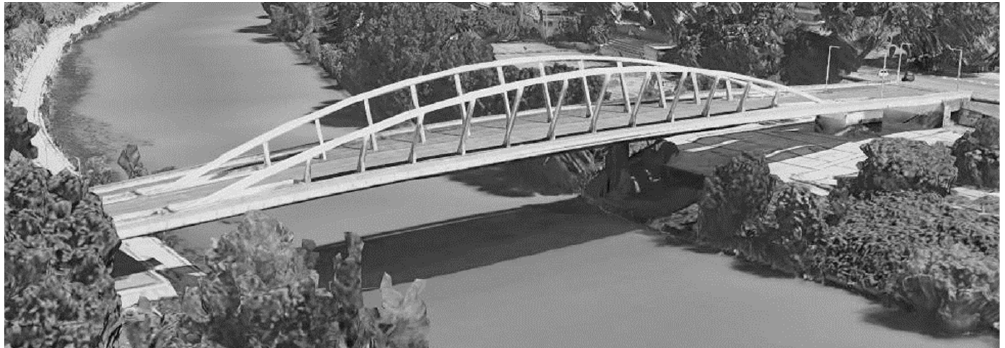
Figure 1. Ponte della Musica in Rome.